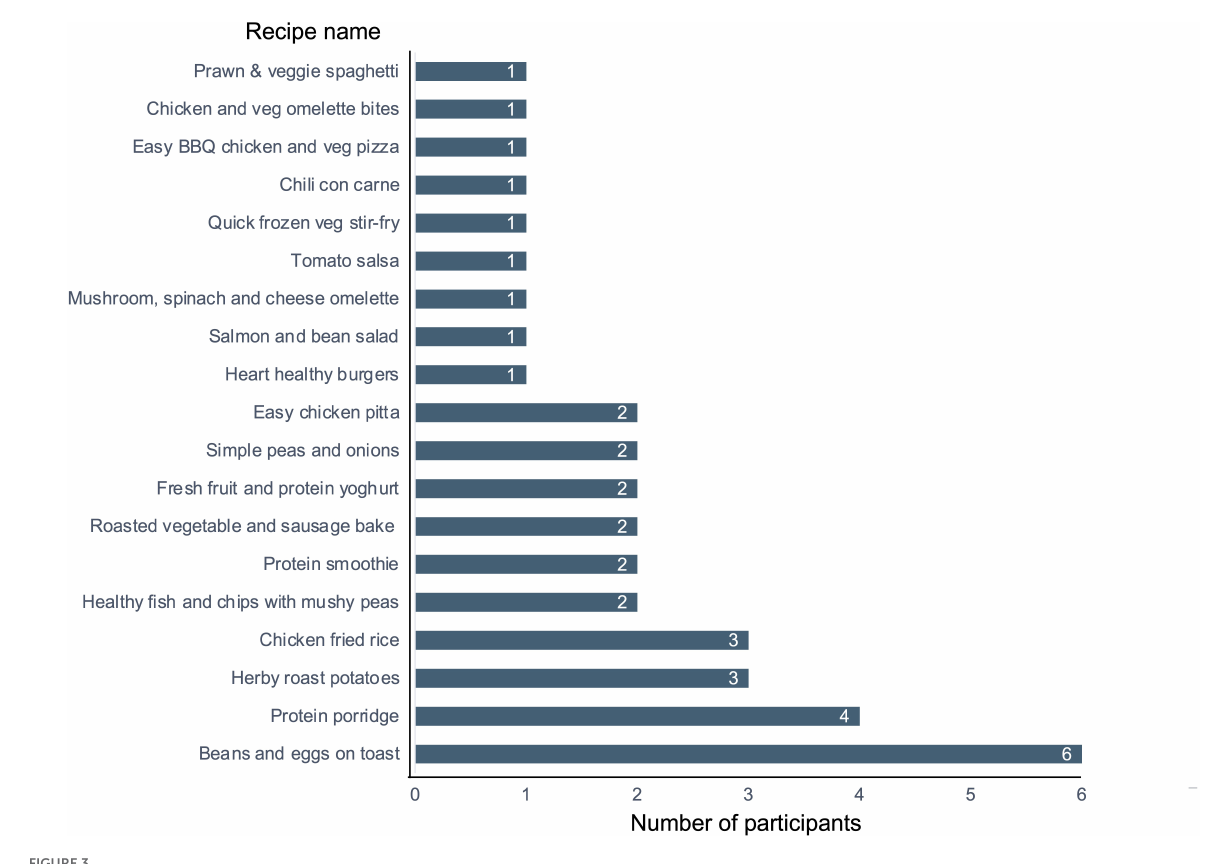
FIGURE3 Recipes trialed by participants. Numbers presented represent the number of participants that trialed a specific